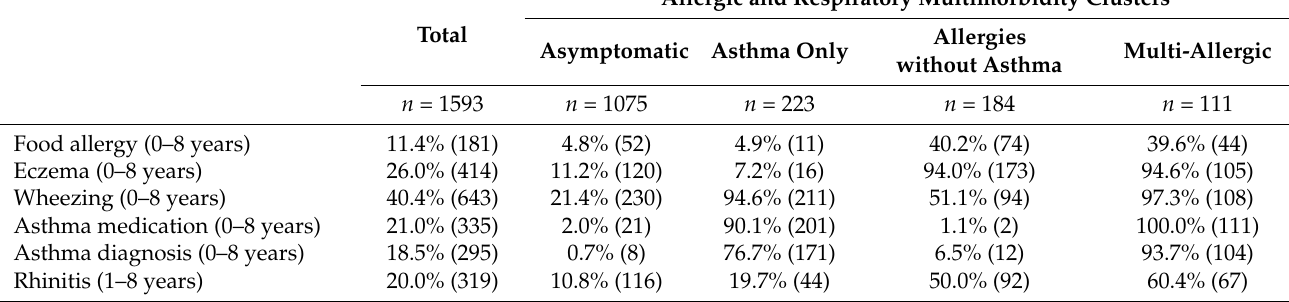
Table 2. Prevalence of allergic and respiratory diseases in children up to 8 years according to the allergic and respiratory multimorbidity clusters ( n = 1593). Allergic and Respiratory Multimorbidity Total